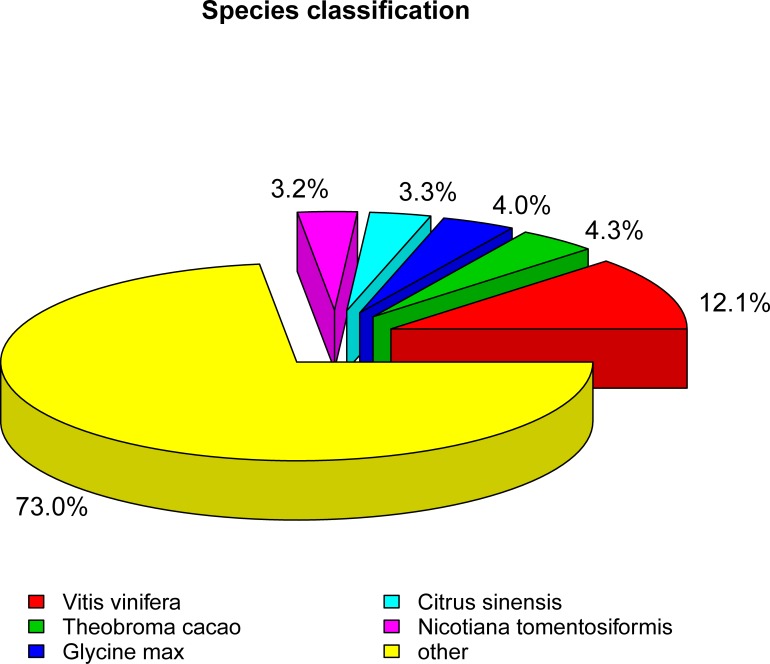
Homology search of R. patientia unigenes with other species by BLASTx to the NR database.